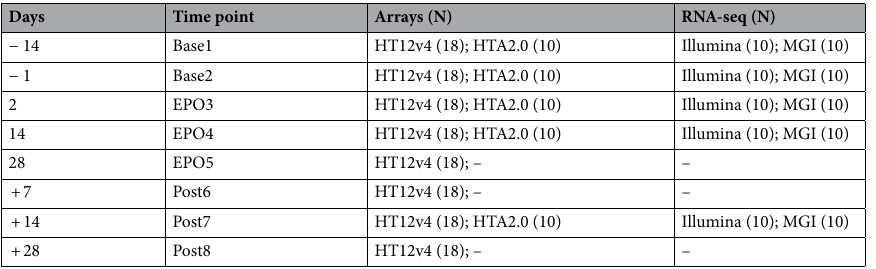
Table 1. Experimental time points, array and RNA-seq platforms and number of individuals analysed in the study. Samples collected across all eight time points were previously subjected to analysis on the HT12v4, and the raw intensities were re-analysed in the current study. Base1 severed as the baseline for gene expression comparisons. N: the number of individuals. HT12v4: illumina HumanHT-12 v4 expression BeadChip; HTA2.0: GeneChip HTA2.0; Illumina: Illumina NextSeq 500; MGI: MGI DNBSEQ-G400RS. –: not